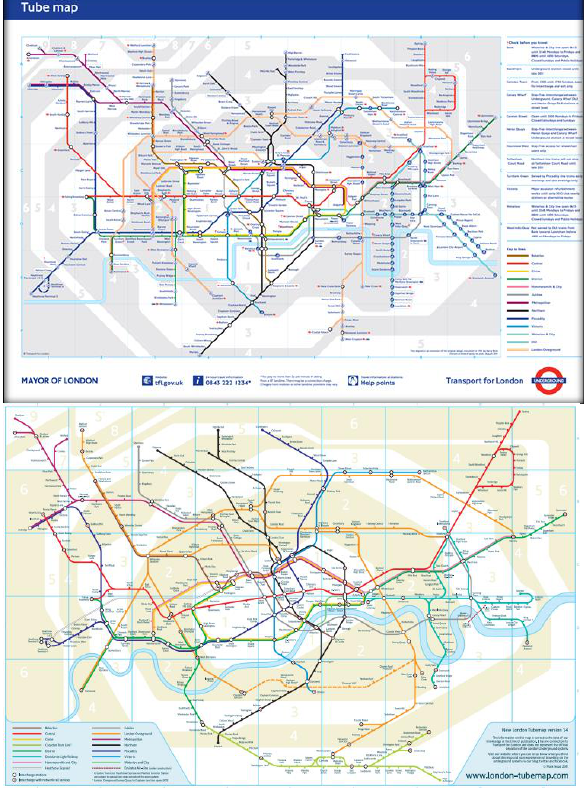
Figure 1 Two types of Schematic maps for London Tube. Upper: official version; Lower: New design by Noad